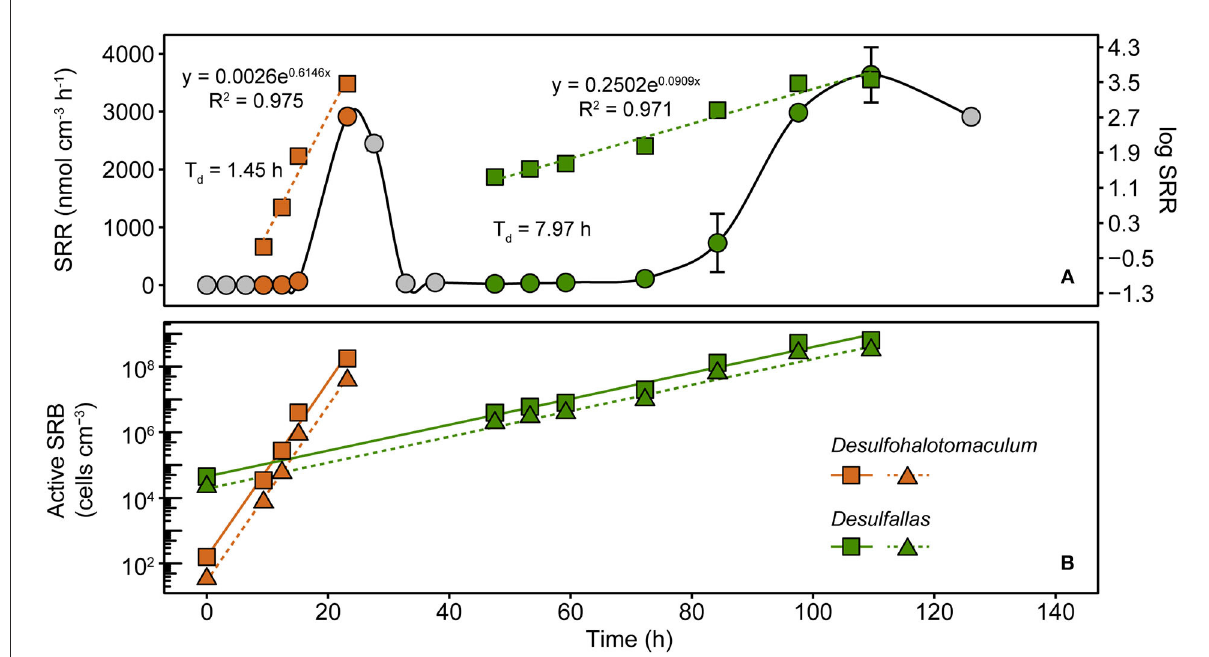
FIGURE4 Sulfate reduction rates (SRRs) catalyzed by populations of sulfate-reducing thermophiles enriched in sediments heated to 50 ◦ C. SRRs are plotted as an average of duplicate measurements from discreet subsampling intervals (A) . Exponential increases in SRR were observed in two distinct time intervals, between 9 and 23h and 47 and 110h. These two phases are evident when plotting the same data on linear (circles; left y-axis) and logarithmic (squares, right y-axis) scales. SRR enabled cell abundances to be estimated for two thermophilic, spore-forming SRB populations belonging to Desulfohalotomaculum and Desulfallas (B) . For both populations, two different assumptions for the biovolume of a single SRB cell were used to estimate abundance. Squares denote SRB estimates based on cellular biovolume of 1.0 pg µ m − 3 , the median determined by comparing 68 different SRB strains (de Rezende et al., 2017). Triangles denote SRB estimates that assume cellular biovolumes for the corresponding populations determined from cellular morphologies of two SRB strains isolated in this study. Solid and dashed lines represent linear smoothers fitted onto the symbols for each set of estimated cell numbers. Doubling times shown next to the estimated abundances were calculated from the exponential equations for increasing